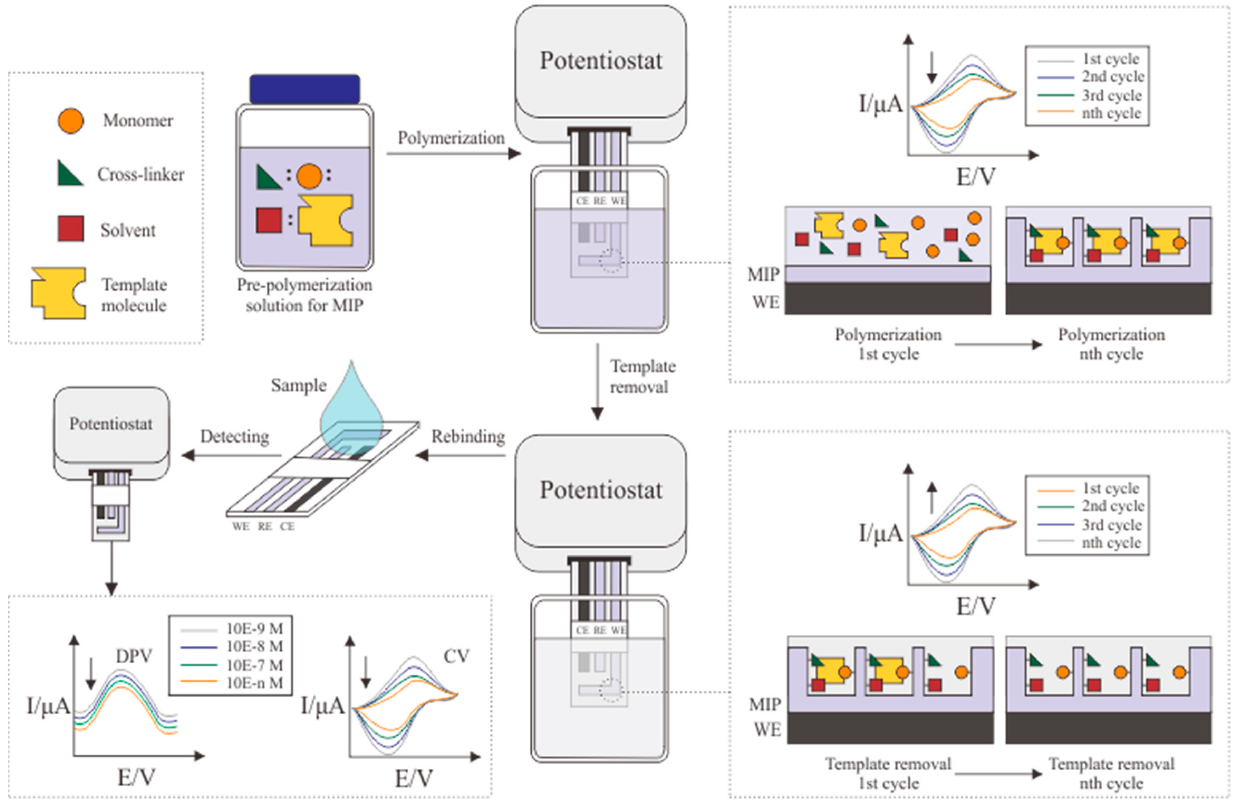
Figure 4. Schematic illustration of MIP formation via surface imprinting.